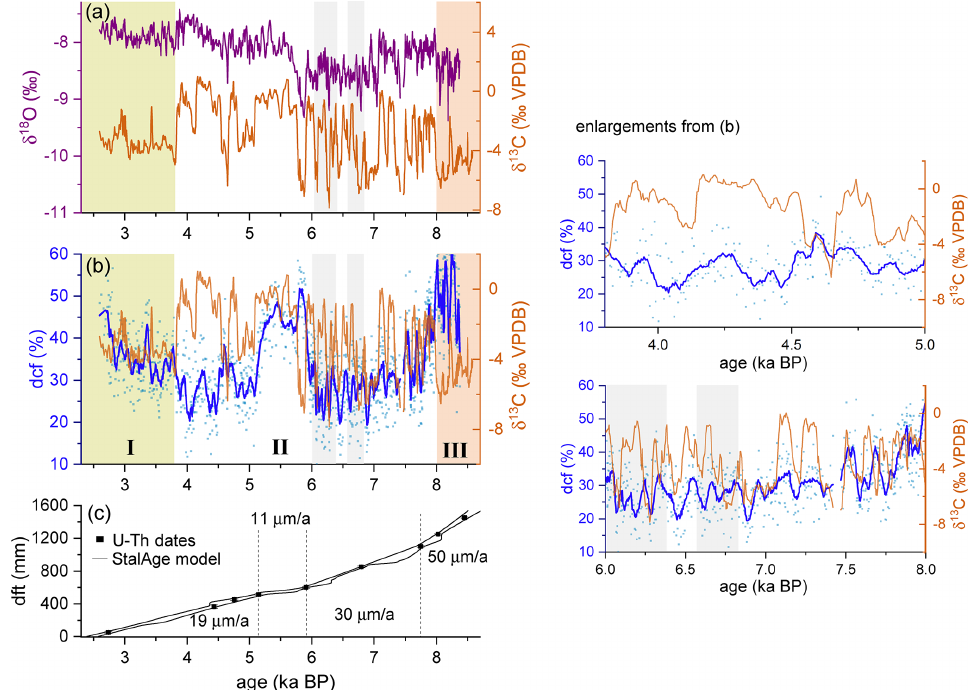
Figure 3. δ 18 O represented by the purple line (Fohlmeister et al., 2013) compared to δ 13 C (orange line) and (b) dcf (light blue dots) with a 21-point SG filter (dark blue line) plotted against age and compared to δ 13 C. The yellow, white and orange shaded areas represent phases with distinct stable isotope characteristics. Roman numerals indicate the three subsections discussed in the text. Light grey shaded areas mark regions where the SG filter was determined with lower confidence. Enlargements of this graph are shown in the right panel. (c) Growth history of SPA 127 obtained by StalAge applied to dated depths (black squares, errors are smaller than the symbol size). Numbers represent average growth rates of the individual